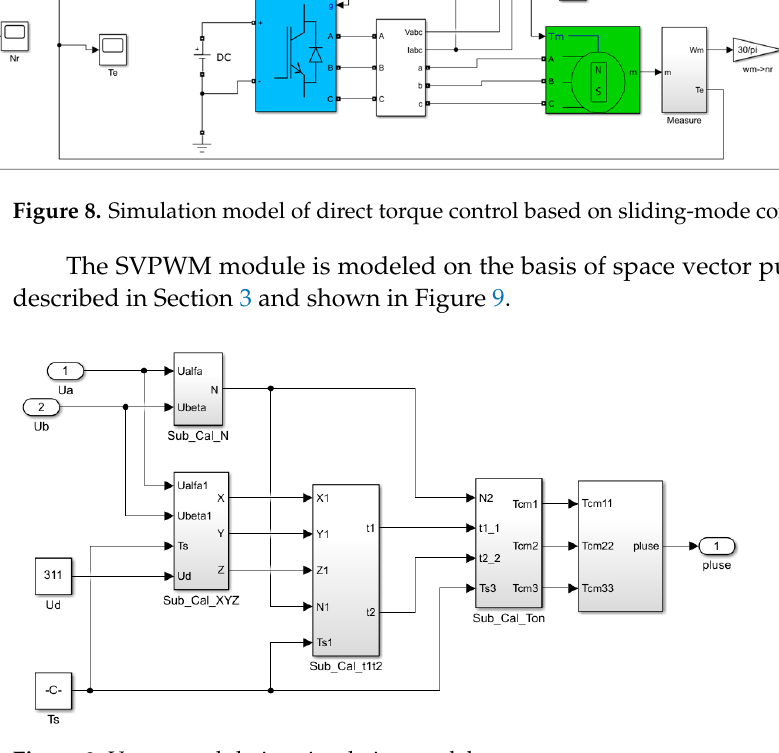
Figure 9. Vector modulation simulation model.